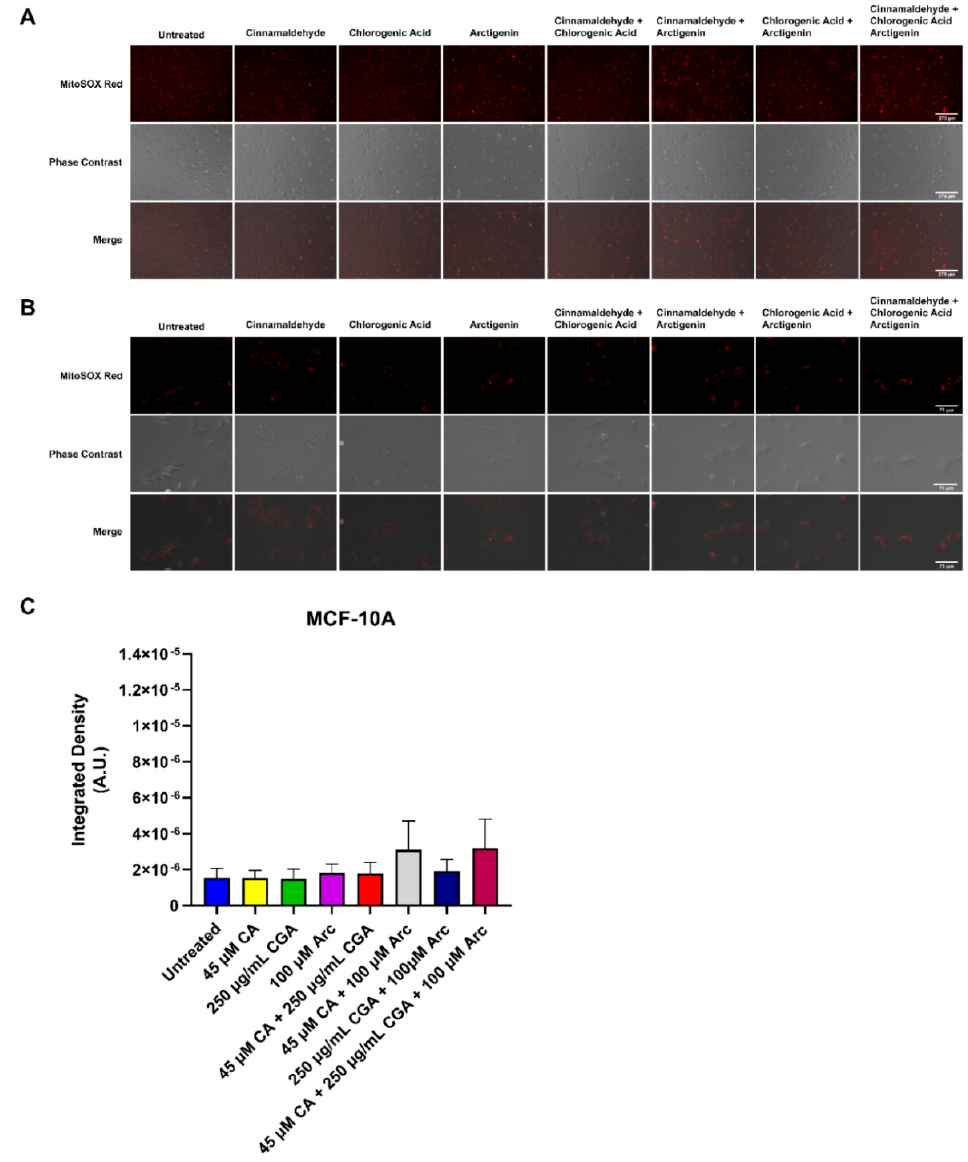
Figure 11. Superoxide production in MCF-10A normal mammary epithelial cells treated with 45 μ M CA, 250 μ g/mL CGA, and 100 μ M Arc, alone and in combination, for 2 h. ( A ) Representative fluo- rescence microscopy images of MCF-10A cells treated with CA, CGA, and Arc, alone and in combi-